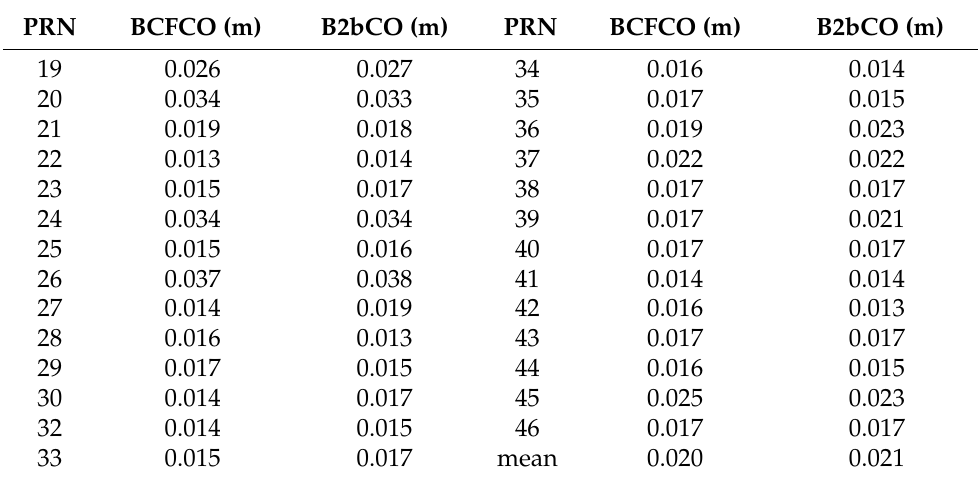
Table 3. The precision (STD) of clock offset.